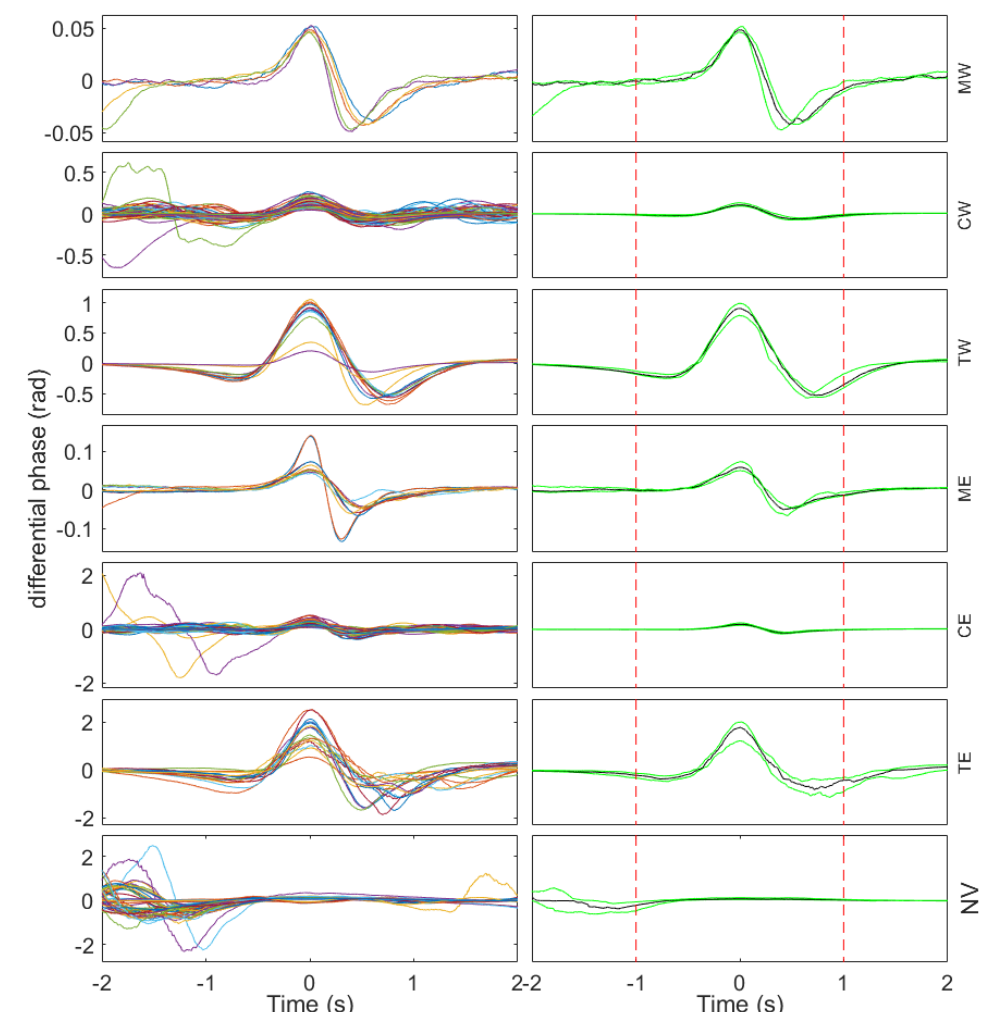
Figure 8. Vehicle signature traces of all the analyzed events grouped by class (left column) and the corresponding median trace (black line) and 25th and 75th percentile signals (green lines) per class (right column). Each row corresponds to one of the analyzed classes: MW, CW, TW, ME, CE, TE, and NV, respectively. The vertical dashed red lines in the left column represent, at each plot, the time instants at − 1 s and 1